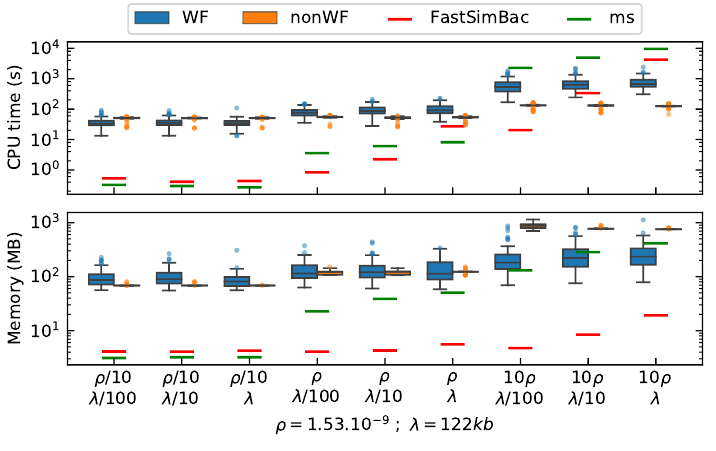
Figure 4 – Distribution of the CPU time and peak memory usage for different recombina- tion rates ( ρ ) and mean recombination tract lengths ( λ ). Parameters used : chromosome 10 − 9 ; Ne = 140k; 30000 generations; RF=25. There are 100 repli- size : 2Mb; µ = 1 . 53 × cates for each combination of ρ and λ . Computation time and memory usage increase with the recombination rate, but not with the recombination tract